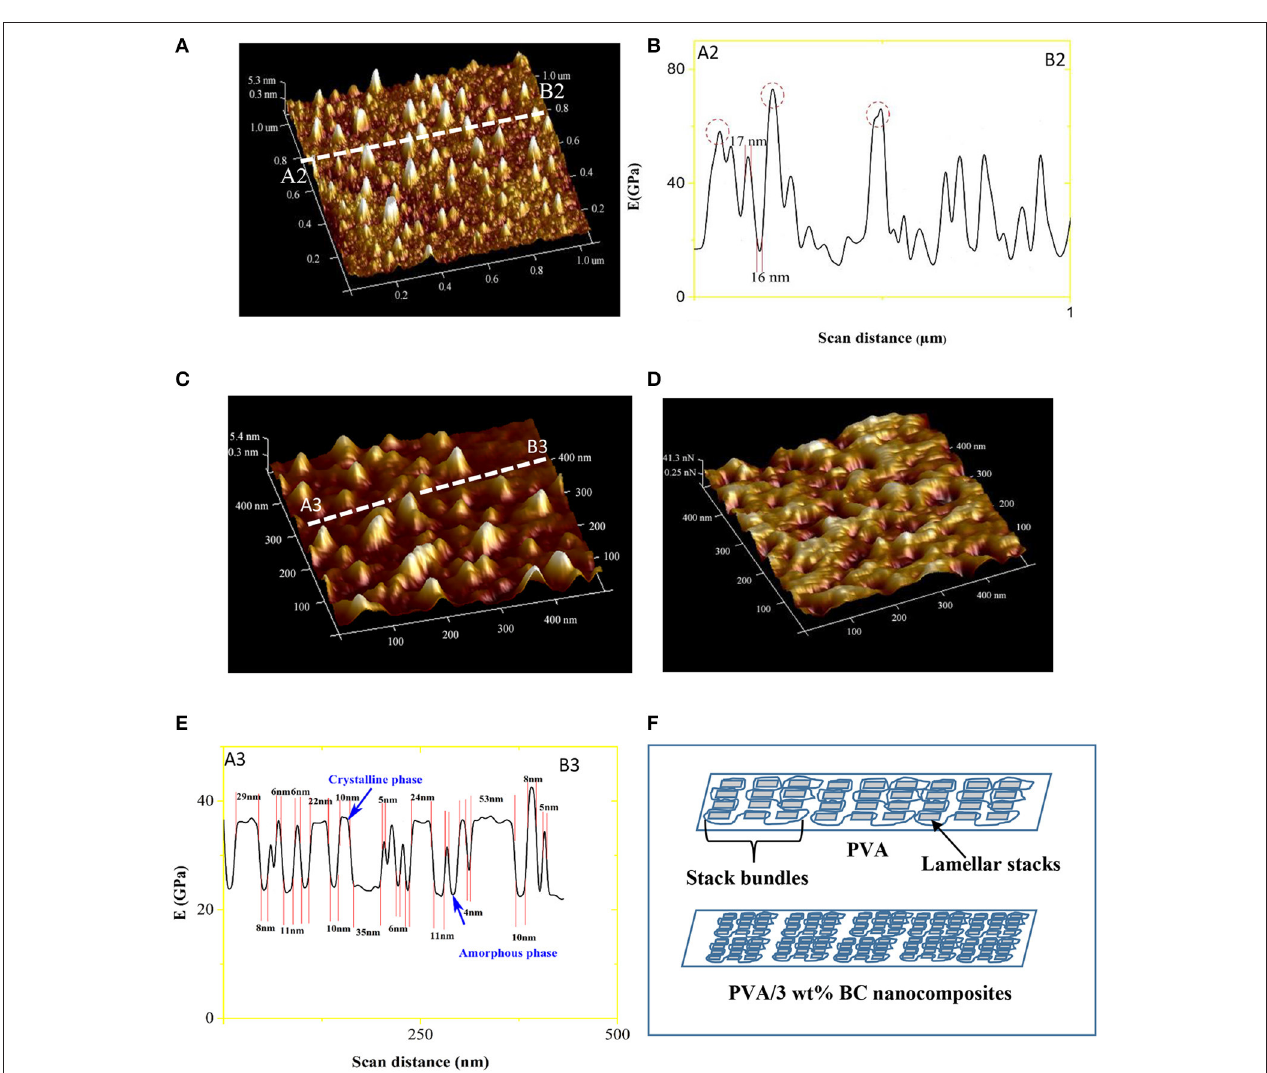
FIGURE 3 | (A) 3D AFM height mapping image of PVA/BC nanocomposites and (B) DMT modulus-scan distance curve for corresponding typical section A 2 -B 2 in (A) , 3D AFM mapping images of PVA/BC nanocomposites for (C) height and (D) adhesion force at high magnifications, (E) DMT modulus-scan distance curve for corresponding typical section A 3 -B 3 in (C) and (F) schematic diagram for bundles of lamellar stacks in both PVA and PVA /BC nanocomposite films.